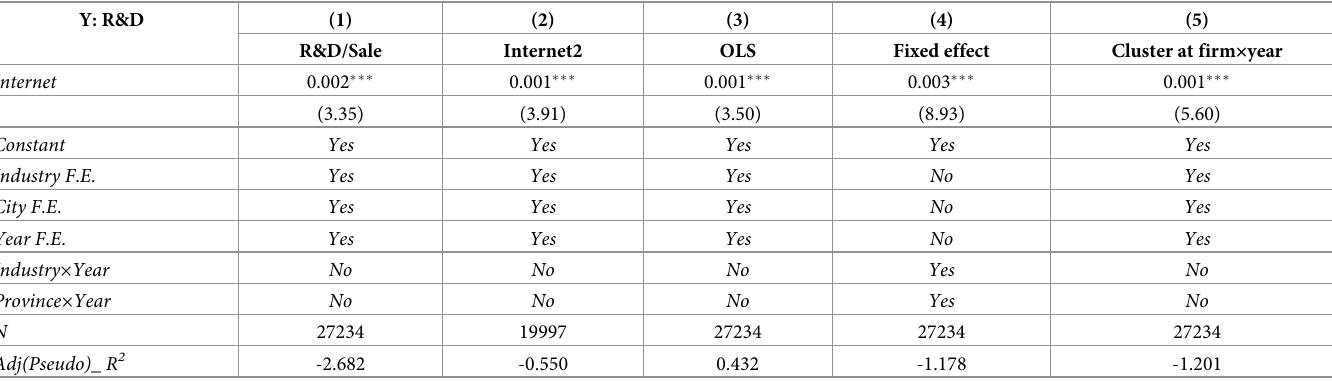
Table 3. Robustness checks: Alternative measures of key variables and empirical